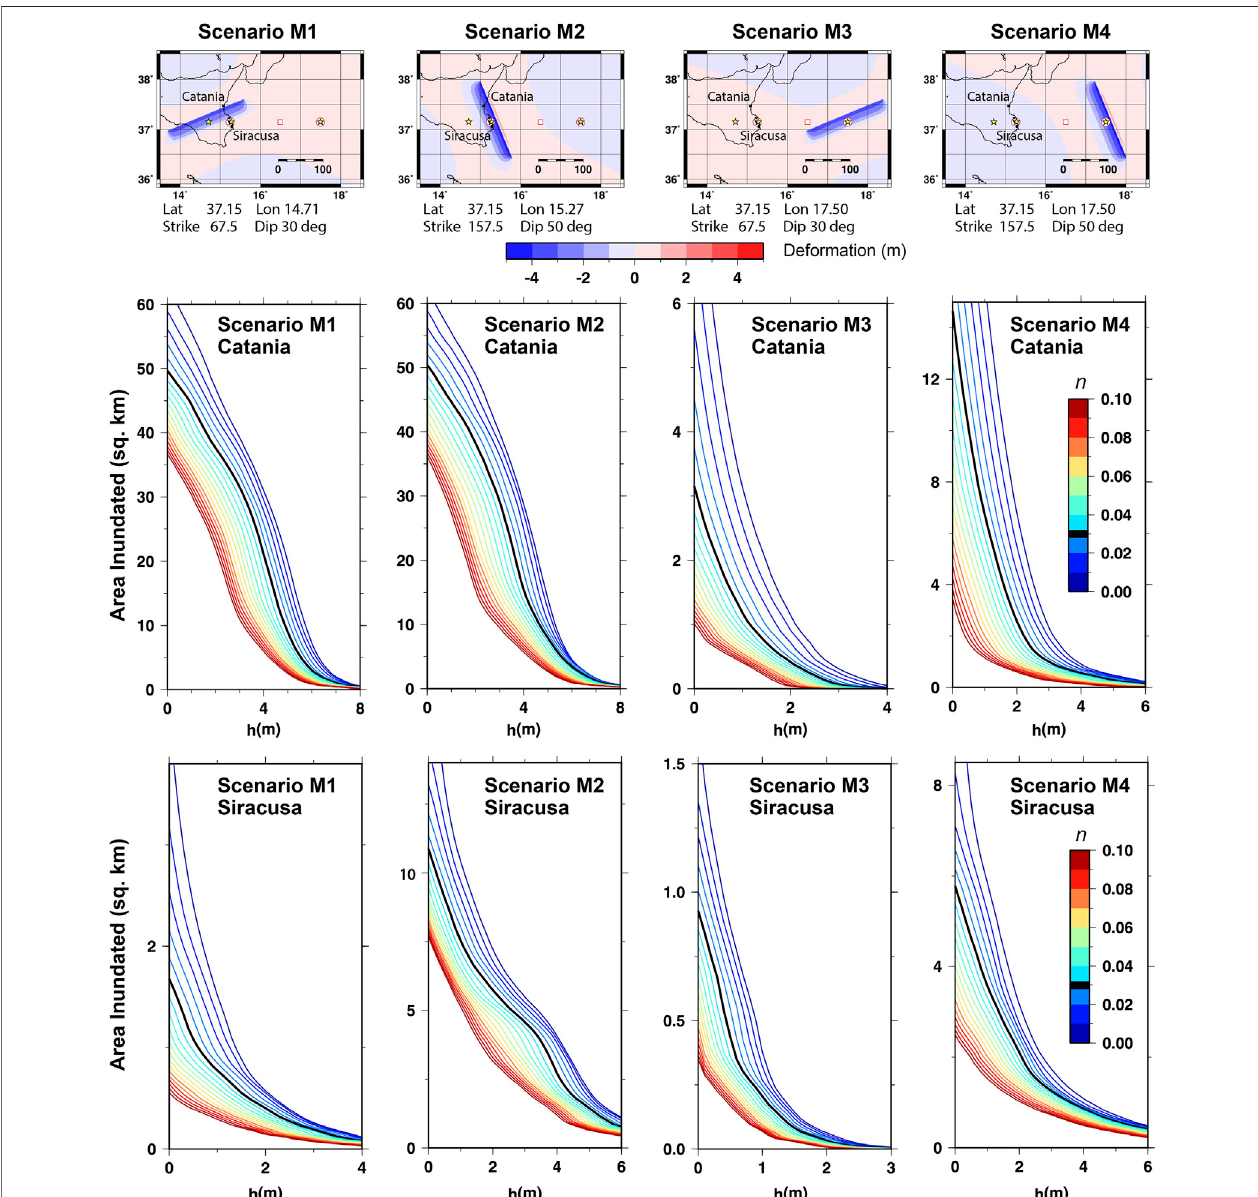
FIGURE3| CumulativeinundationareaplotsforCataniaand Siracusa forthescenariosM1,M2, M3,andM4. Foragivenvalueofh, thecurveindicates theareaof land that was dry prior to the event which has experienced a maximum fl ow depth exceeding h m. The 19 curves in each panel cover values of the Manning friction, n, between0.05and0.95inintervalsof0.005.Thecurvesforn (cid:1) 0.03arehighlightedandcolouredblacktomarkthatthiswasthevalueusedforallcalculationsinGibbons et al.